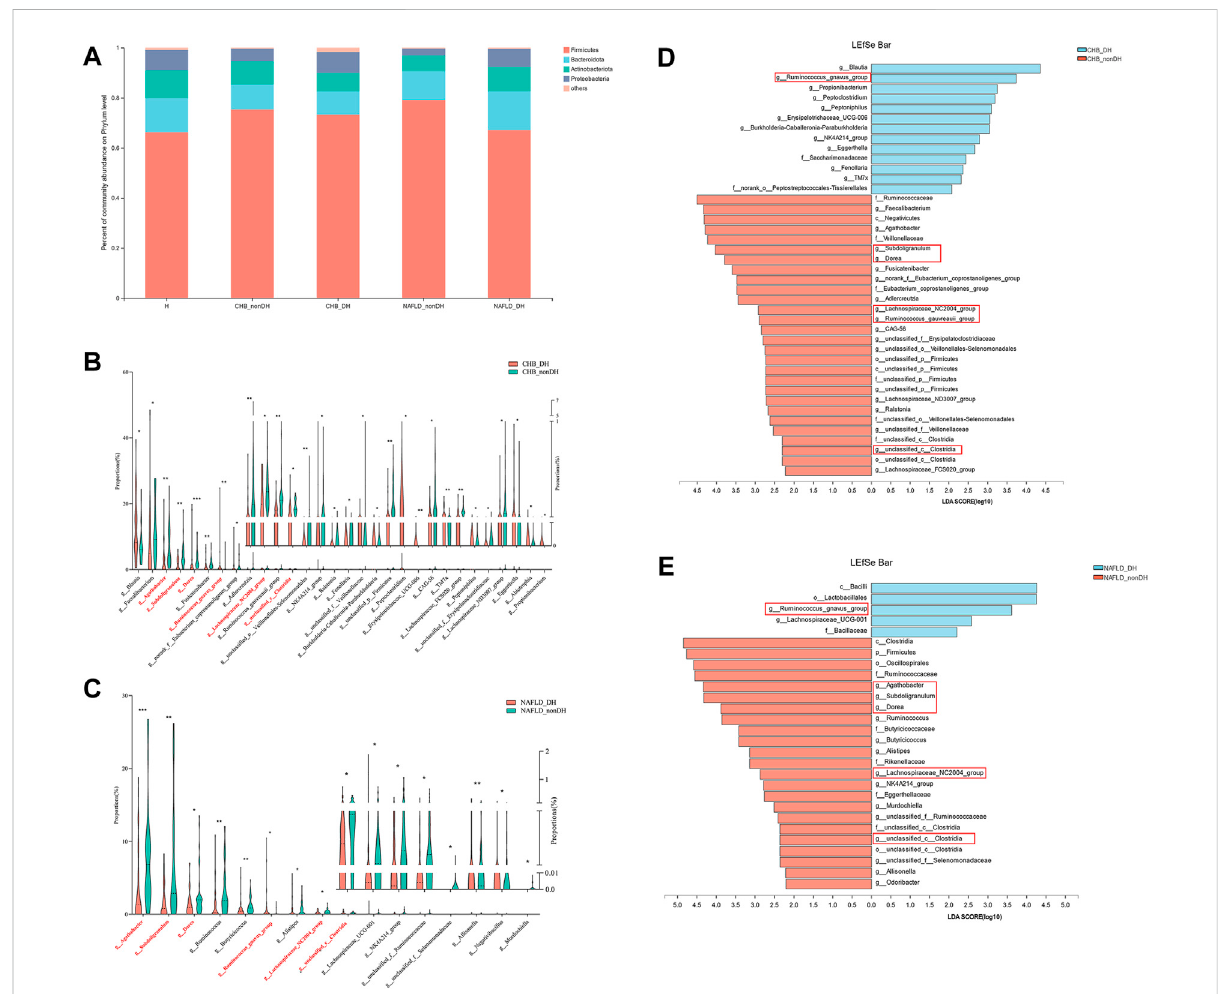
FIGURE 4 Comparison of the gut microbiome in patients with and without DH syndrome. (A) Phylum-level gut microbial composition; (B) the relative abundance of 30 different bacterial genera between CHB_DH and CHB_nonDH patients; (C) the relative abundance of 16 different bacterial genera between NAFLD_DH and NAFLD_nonDH patients; LEfSe analysis between (D) CHB_DH and CHB_nonDH groups; (E) NAFLD_DH and NAFLD_nonDH